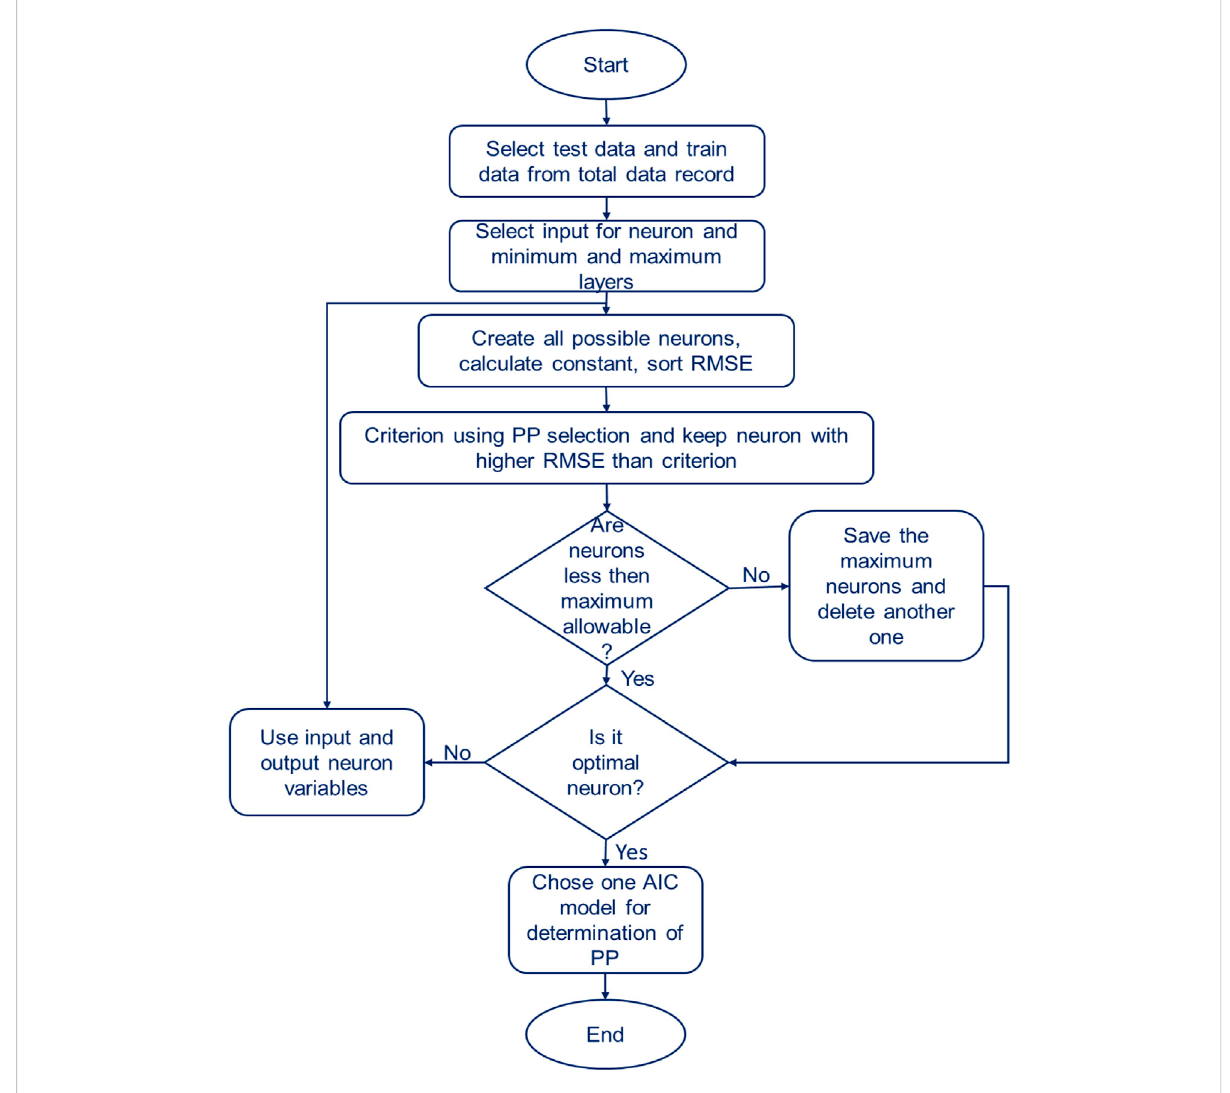
FIGURE 2 GS-GMDH fl owchart for PP